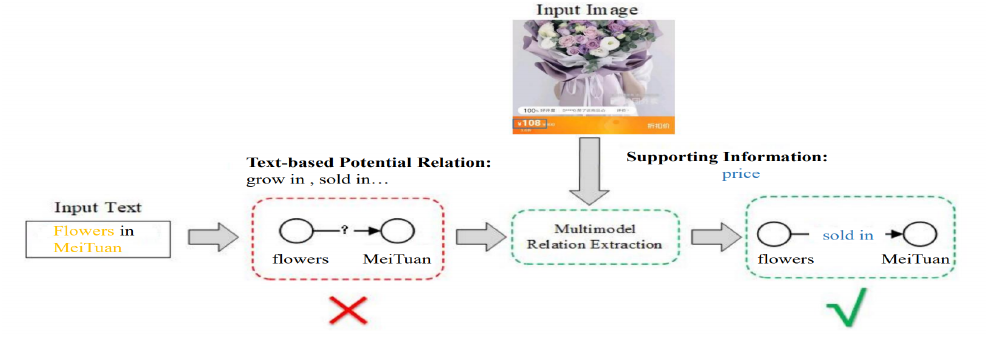
Figure 5. Illustration of visual relation